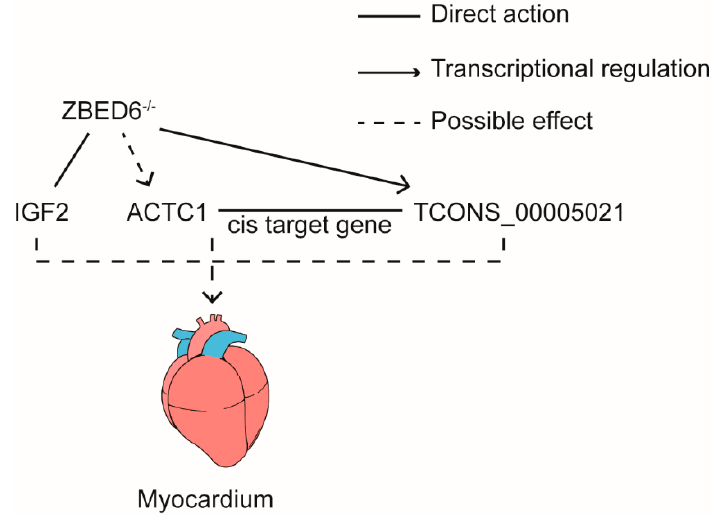
Figure 6. Working model: ZBED6 could directly influence the expression of IGF2 and TCONS_00005021. Also, TCONS_00005021 regulates the expression of ACTC1 by cis-mode.